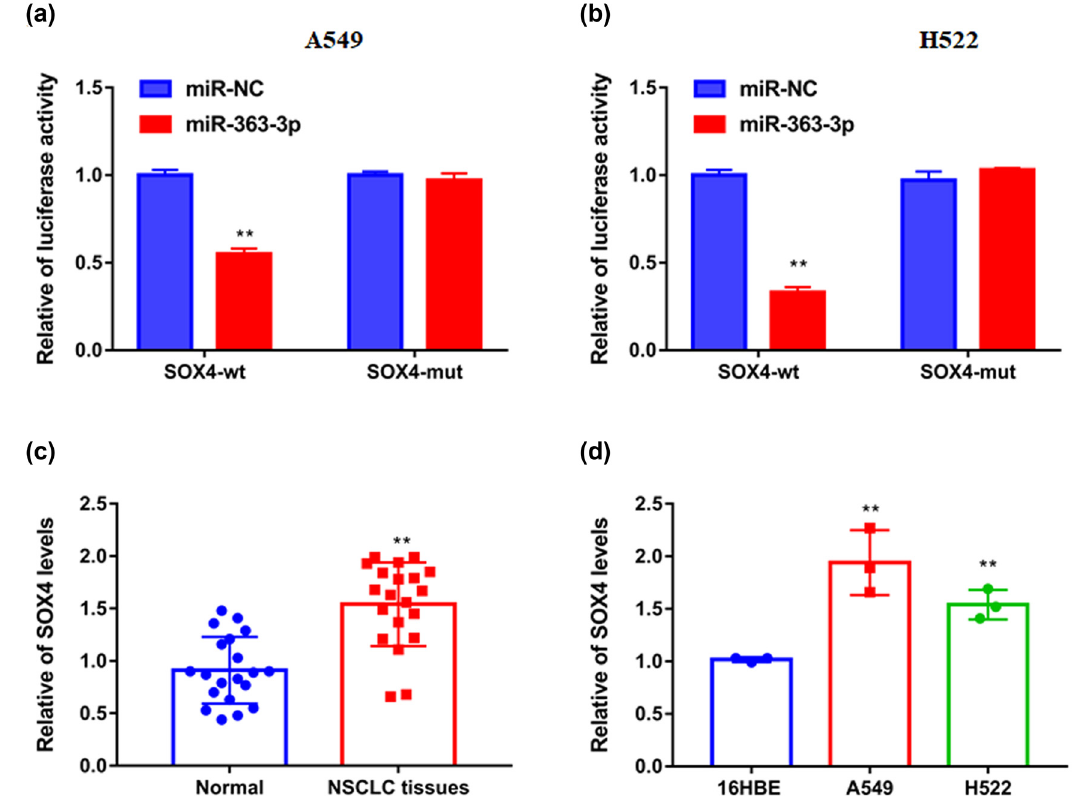
Figure 6: SOX4 was targeted by miR - 363 - 3p. ( a and b ) The connections between SOX4 3'UTR and miR - 363 - 3p were exhibited using dual - luciferase reporter assay. ( c and d ) The mRNA levels of SOX4 in the paired NSCLC samples and adjacent tissues, together with BEAS - 2B cells and NSCLC cell lines ( A549 and H522 ) , were gaged by qRT - PCR. ** P <